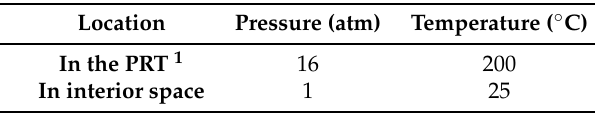
Table 8. The initial state of the